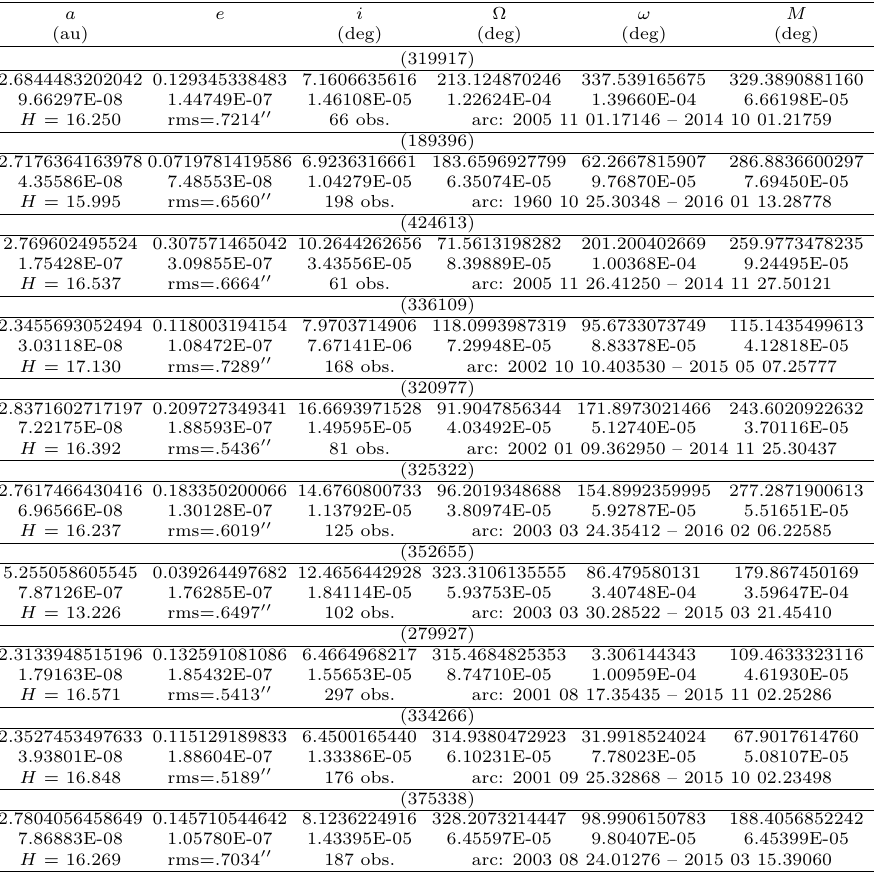
Table 3. High precision orbital elements of the asteroids discovered at the Mol˙etai Observatory in 2008–2009. The epoch JD2457600 = 2016 July